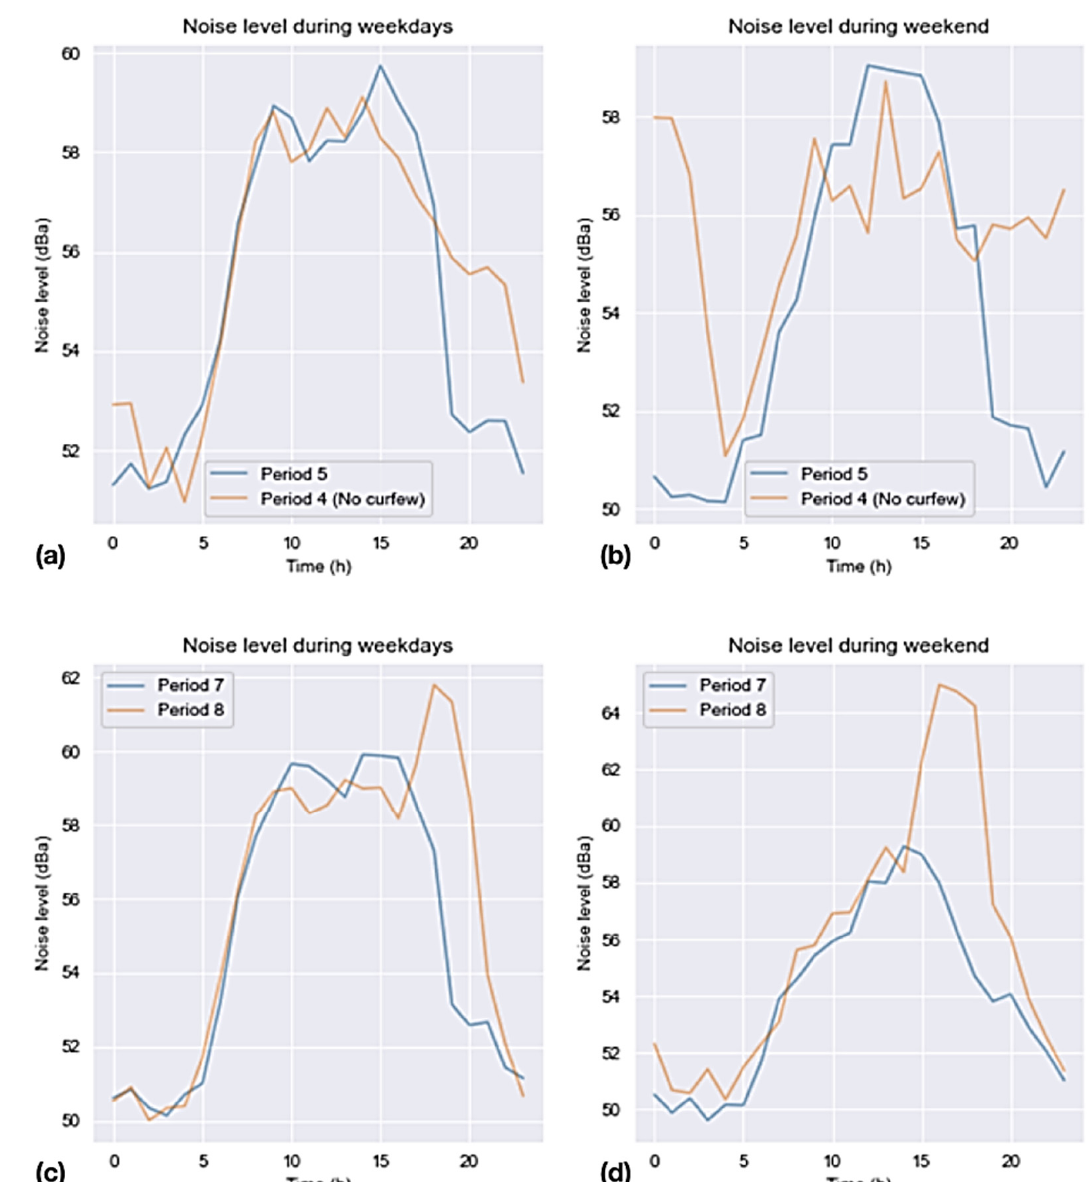
Figure 9. Comparison of the average noise level by hours ( a ) during the weekdays between a period with curfew and one without, ( b ) during the weekend between a period with curfew and one without, ( c ) during the weekdays between periods with different curfew schedules and ( d ) during the weekend between periods with different curfew schedules on a commercial area.